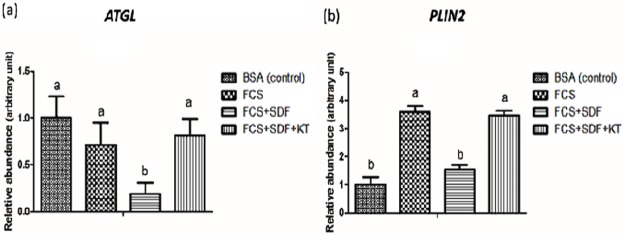
Relative abundance of transcripts for genes related to lipid metabolism in cumulus cells after 24 h IVM with BSA (control) or 10% FCS with or without phosphodiesterase 5 inhibitor (10−5 M SDF) associated or not with PKG inhibitor (10−5 M KT).Data are expressed as the mean ± SEM of five replicates. (A) ATGL, adipose triglyceride lipase; (B) PLIN2, perilipin 2.